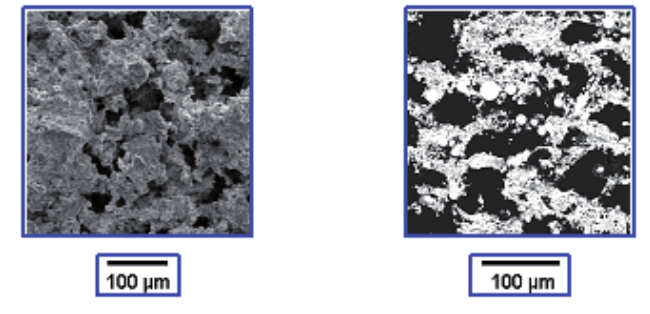
Fig. 11. Computed